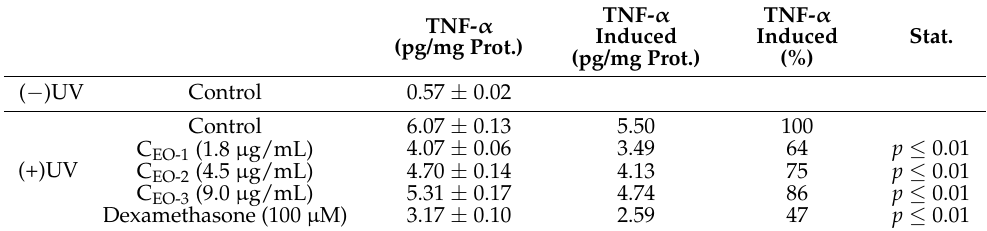
Table 8. Determination of TNF- α